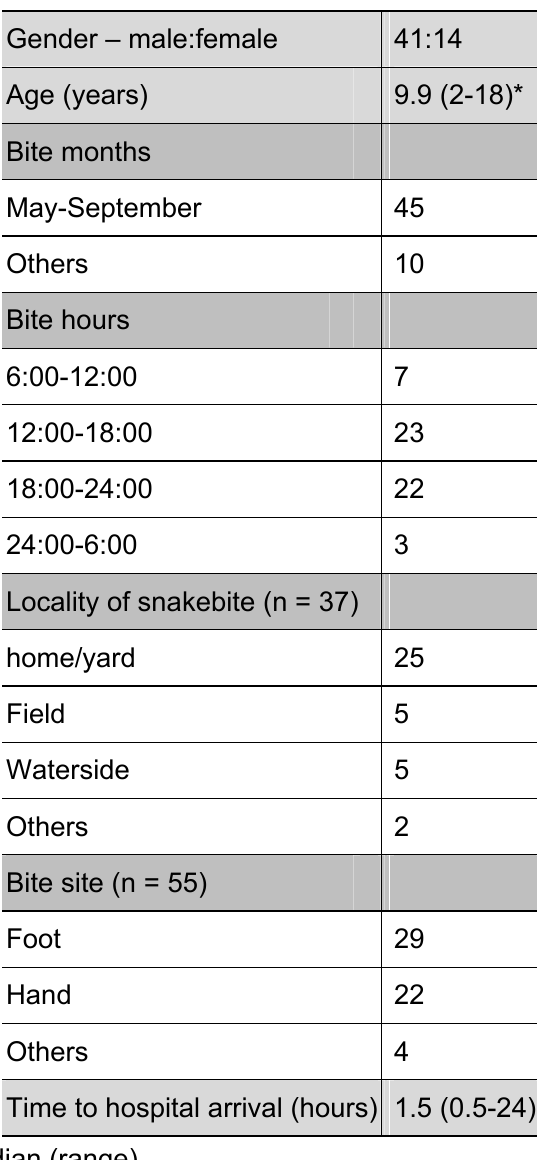
Table 1. Demographic and clinical features of children with snakebites (n = 55) Gender –